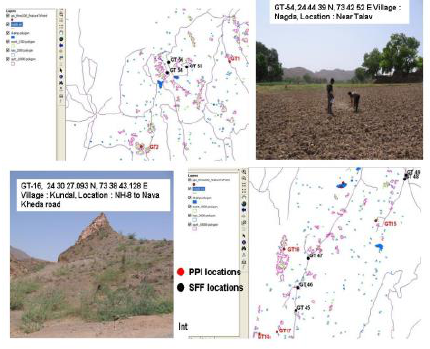
Fig 7 SFF and PPI locations and corresponding ground truth sites